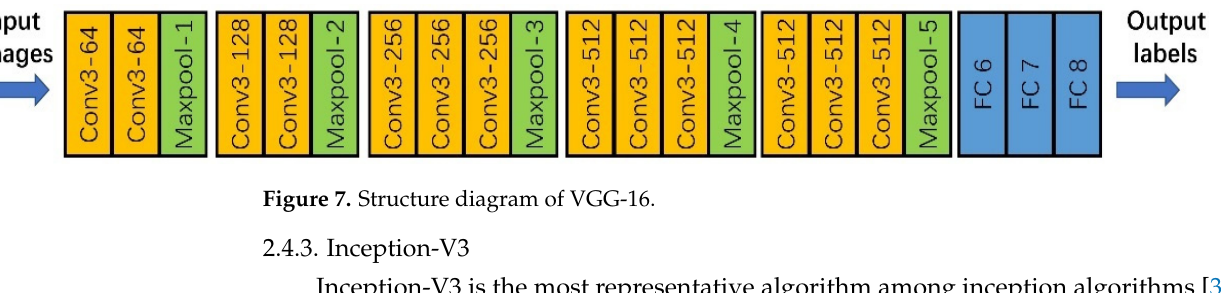
Figure 6. Structure diagram of the convolutional neural network.